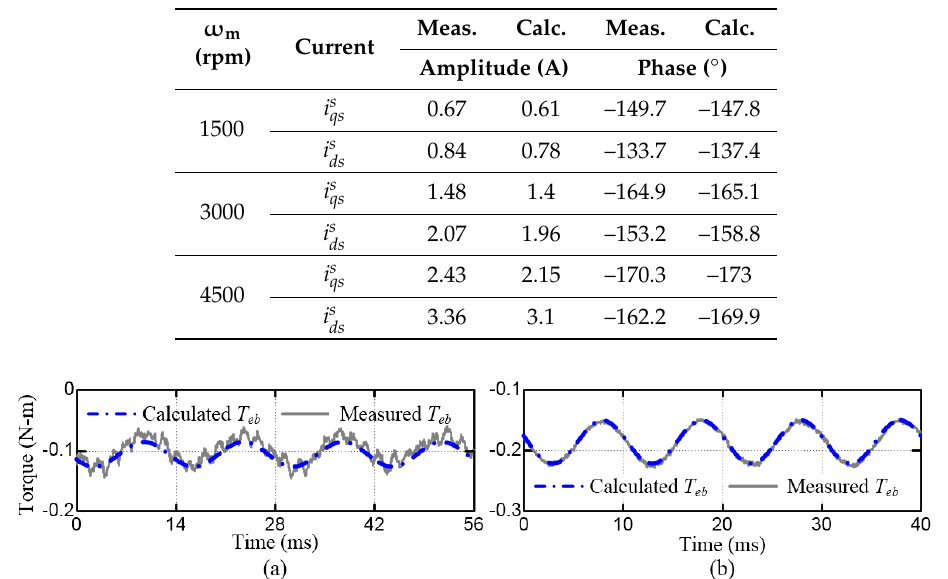
Table 1. Comparison of the measured and calculated currents at various speeds.